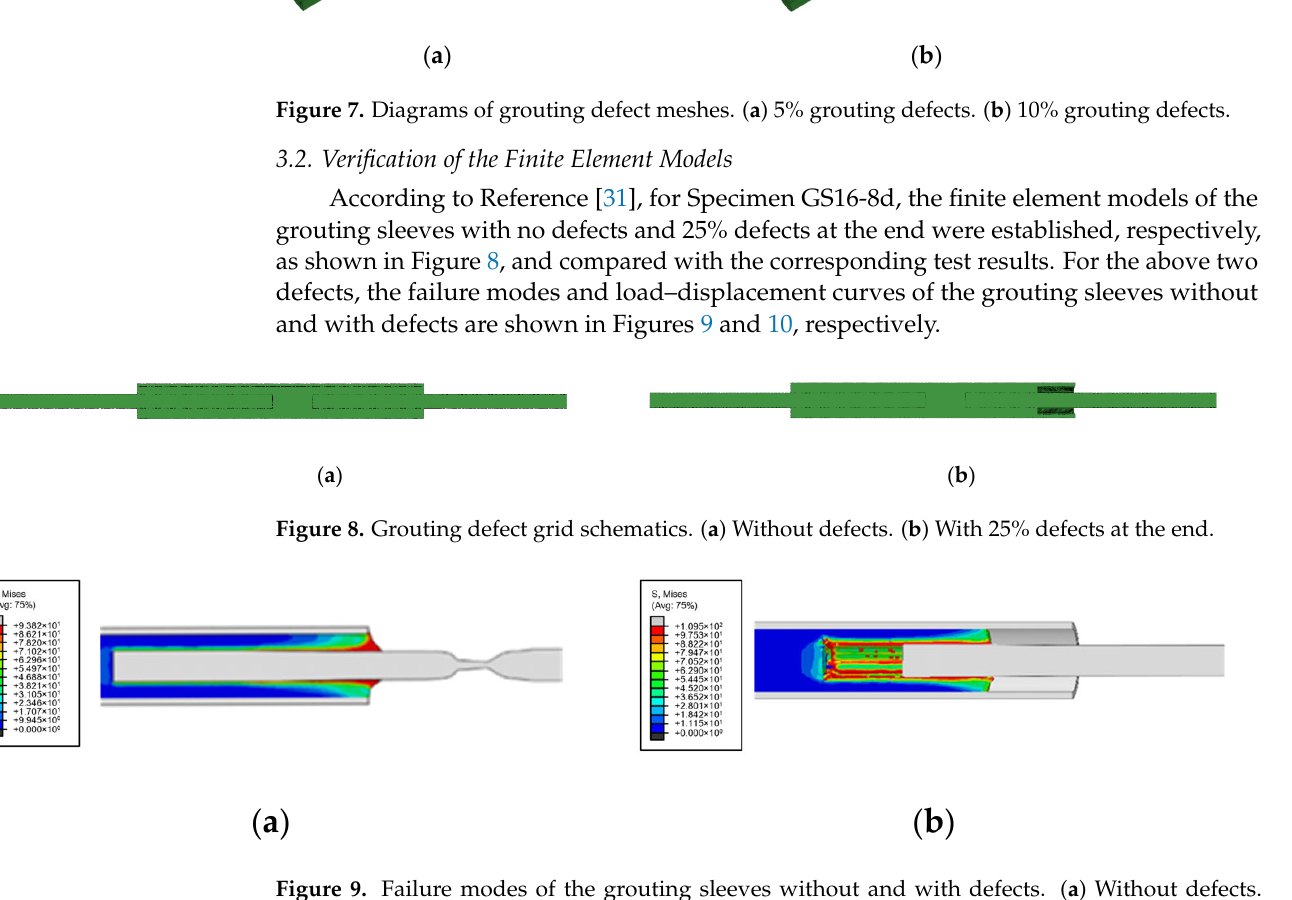
Figure 7. Diagrams of grouting defect meshes. ( a ) 5% grouting defects. ( b ) 10% grouting defects.